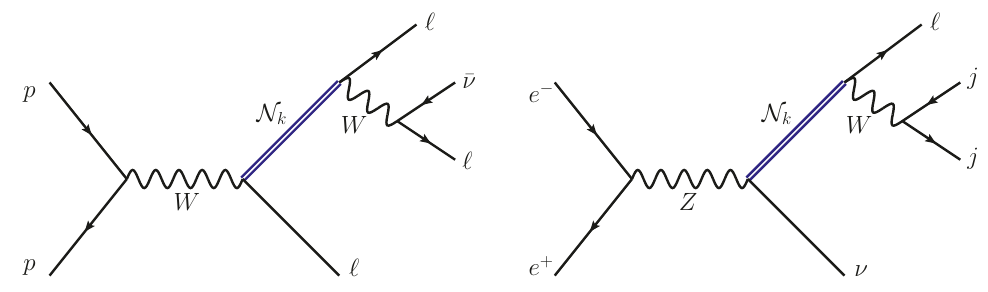
Figure 7 . Production of heavy clockwork modes